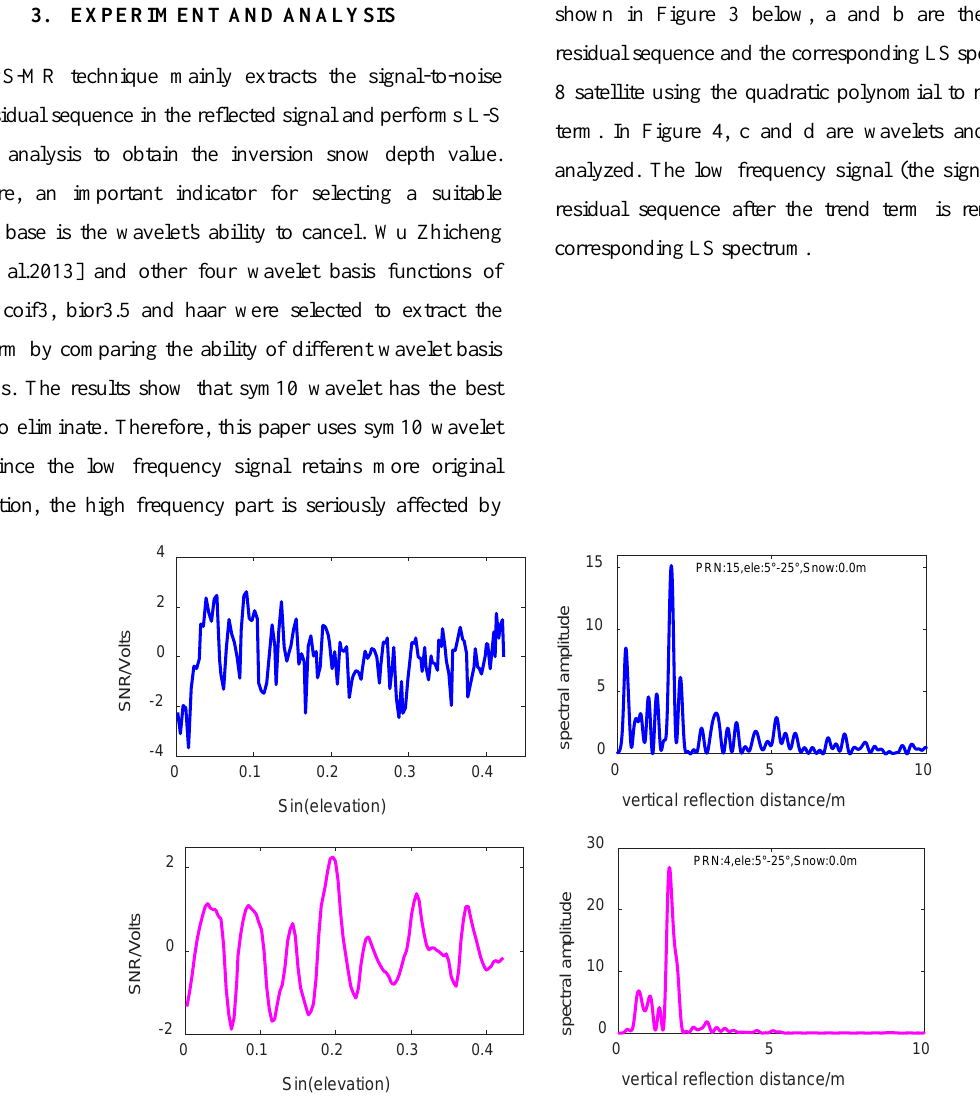
Figure 2 L1 band SNR residual sequence and L-S